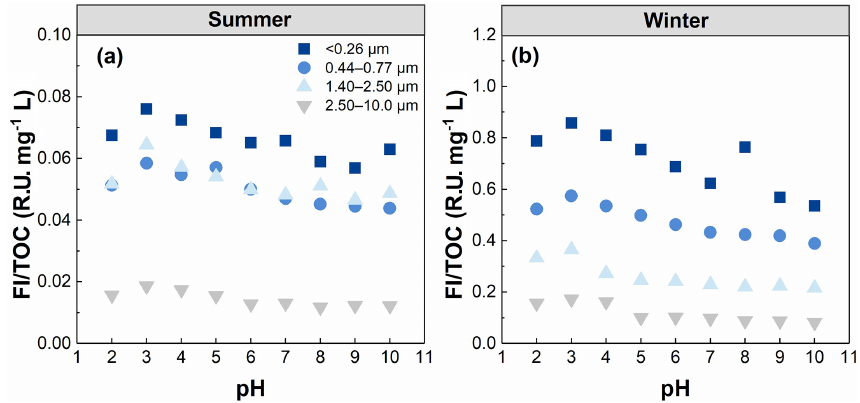
Figure 7. pH dependence of the FI / TOC for WSOC in particles of different sizes in (a) summer and (b) winter in the pH range of